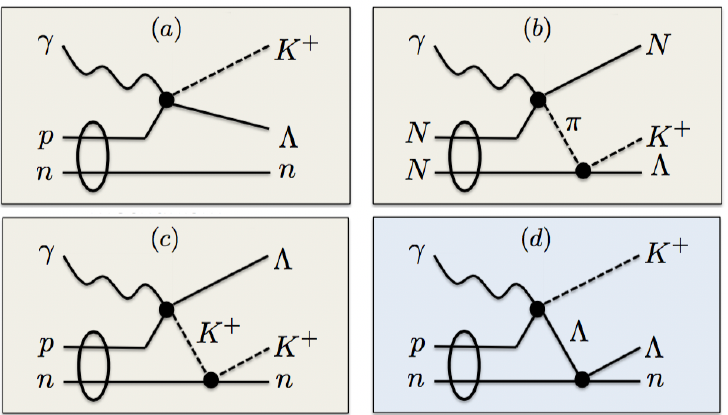
Figure 1: Four main mechanisms that contribute to the reaction γ d → K + Λ n accord- ing to theoretical models [ 1,2 ] : (a) quasi-free Λ K + photoproduction on the proton; (b) pion mediated production; (c) K + rescattering off the spectator neutron; (d) Λ rescattering off the spectator